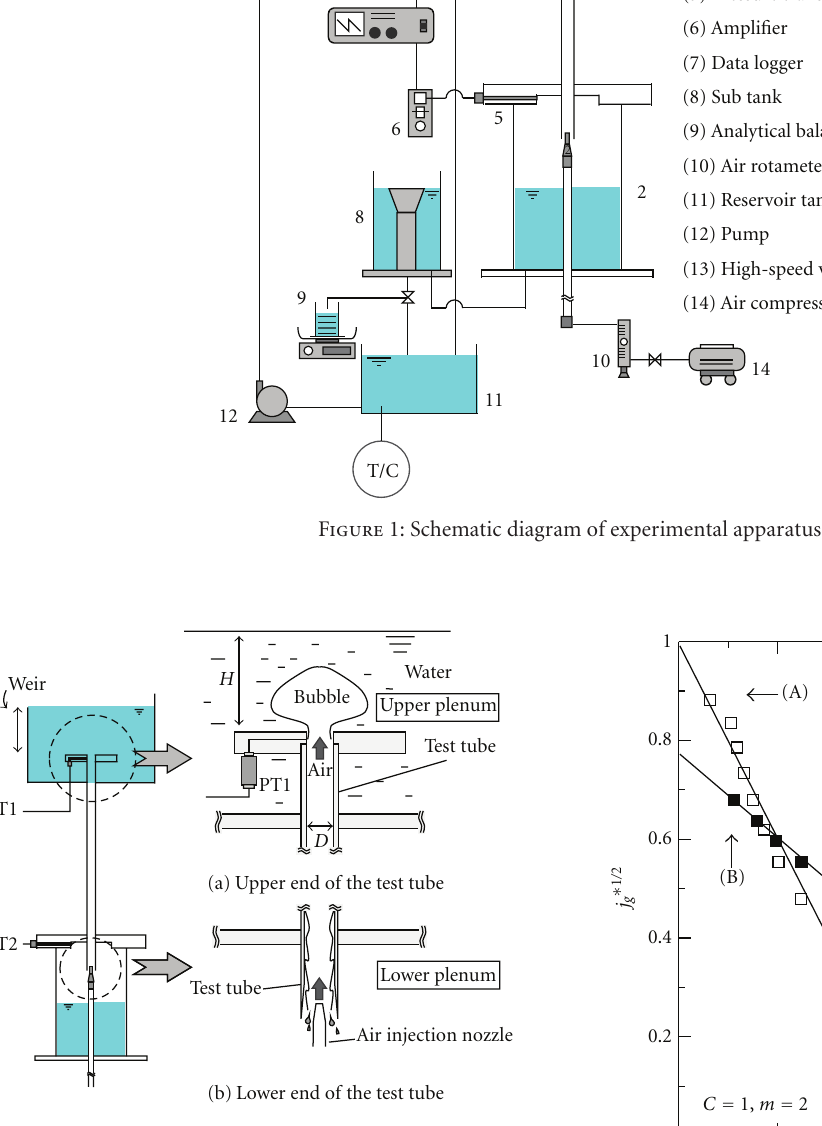
Figure 2: Details of the upper and lower end geometries.